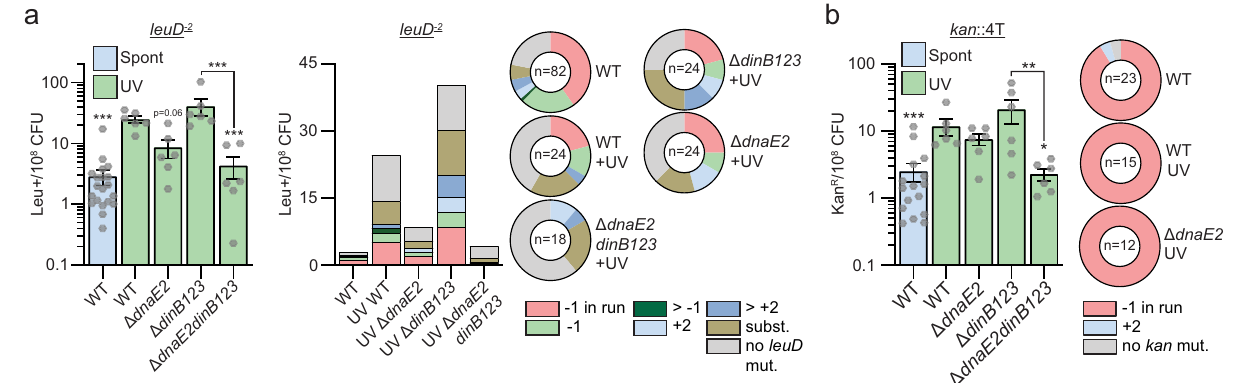
Fig. 7 | DnaE2 is the primary mediator of DNA damage-induced − 1 frameshift mutationsinhomo-oligonucleotide runs.a leu + or b kan R frequency inindicated strains/conditions and relative (pie chart) or absolute (bar chart) frequencies of nucleotide changes detected in leuD or kan coded by color. The number of sequenced leu + or kan R colonies is given in the center of each pie chart. Results